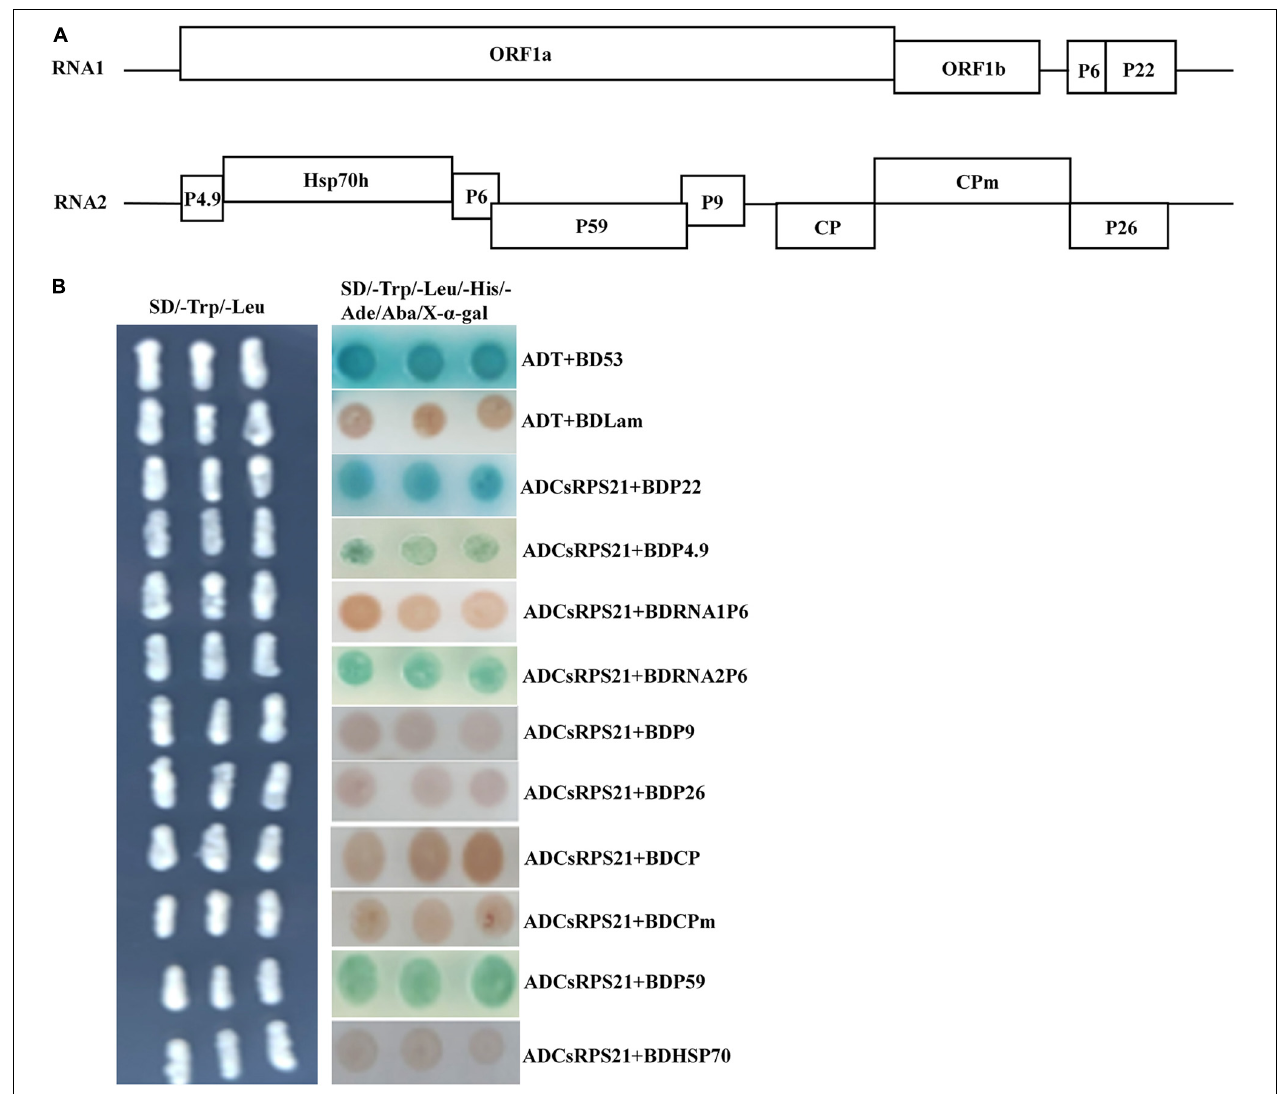
FIGURE 2 | Identification of the interaction between CsRPS21 and CCYV proteins (A,B) ADCsRPS21 was co-transformed with CCYV proteins, as P4.9, P1-6, P2-6, P9, P26, CP, CPm, P59, and HSP70, into Y2HGold yeast cells and plated on a low-(SD/–Trp/–Leu) and high-(SD/–Trp/–Leu/–His/–Ade/Aba/X- α -gal) stringency selection media. ADT + BDP53 and ADT + BDLam served as positive and negative controls,